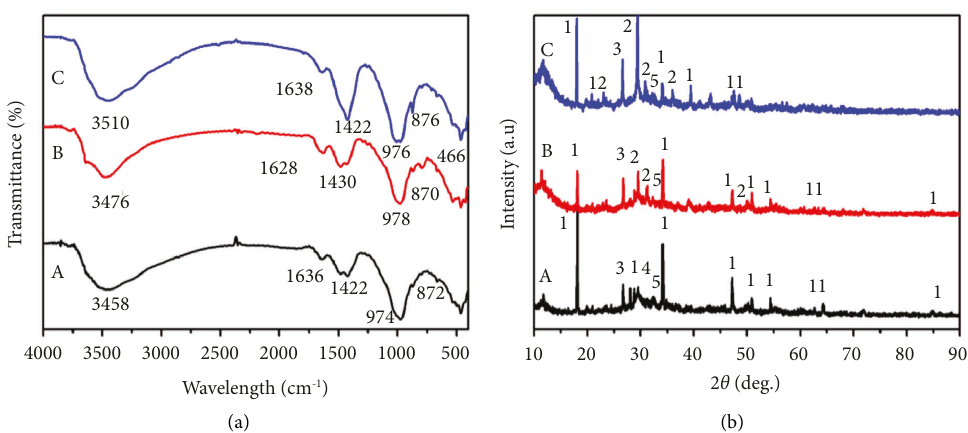
Figure 5: FTIR (a) and X-ray diffraction (b) of bentonite-amended cement formed in deionized water A, bacterial suspension B, and bacterial suspension and reaction solution C (1: CH-portlandite (Ca(OH) 2 ); 2: calcite (CaCO 3 ); 3: quartz (SiO 2 ); 4: C-S-H-calcium silicate hydrate (Ca 5 Si 6 O 16 (OH) 2 ); 5: C 3 S-Alite 3CaOSiO 3 /C2S-Belite (2CaOSiO 3